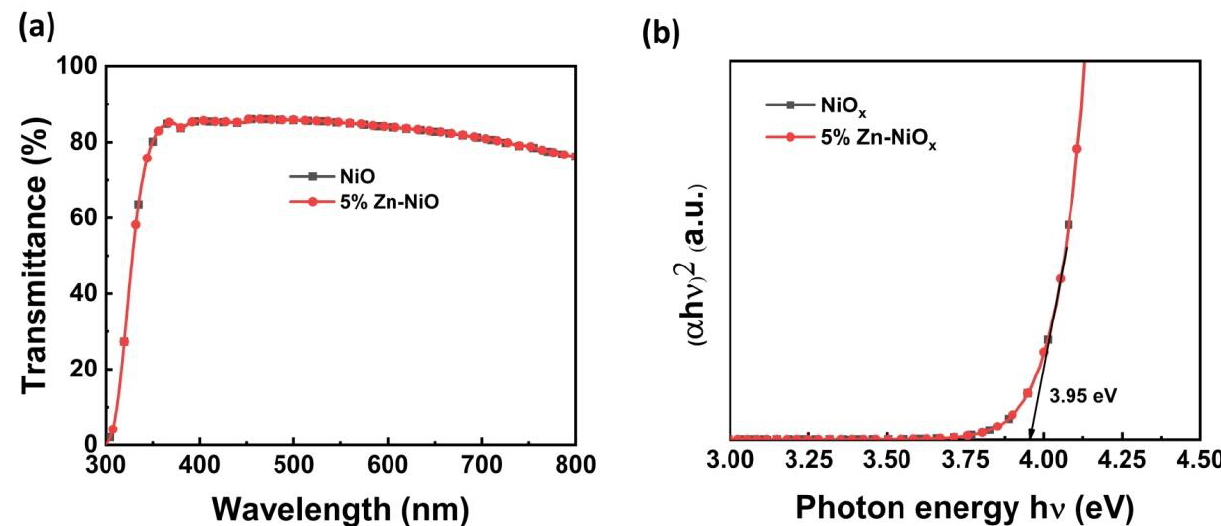
Figure 8. ( a ) Transmittance spectra and ( b ) Tauc plots of NiO x and 5% Zn-NiO x thin films.